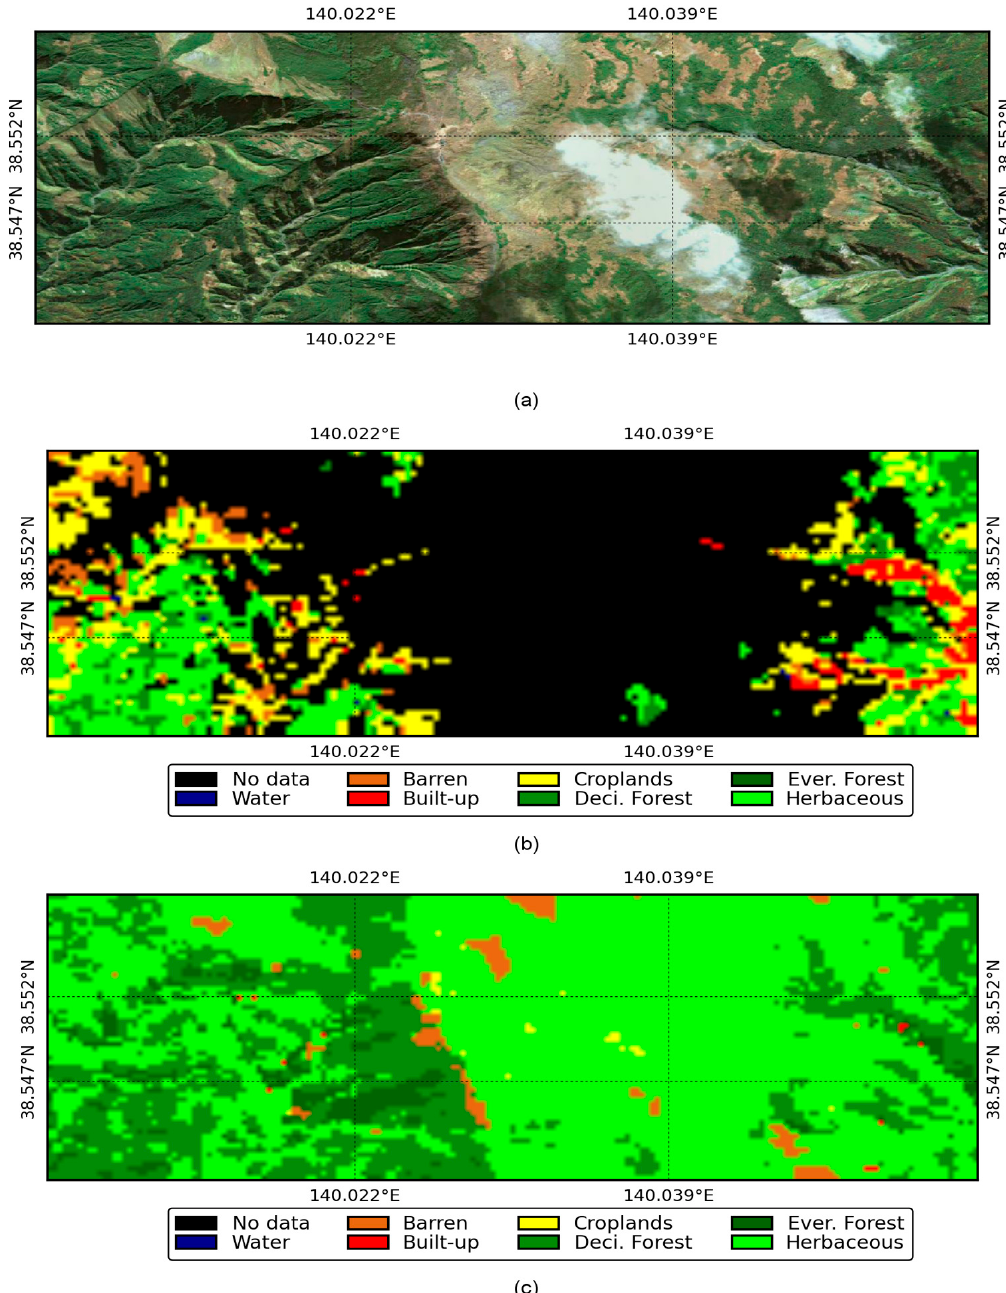
Figure 10. Performance of the JpLC-30 map over the JHR LULC map: ( a ) Google Earth™ image; ( b ) JHR LULC map; ( c ) JpLC-30 map.